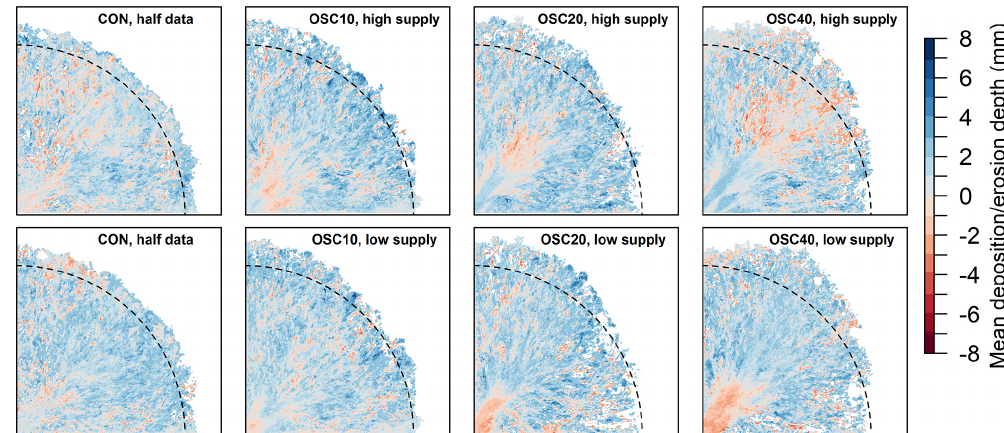
Figure 10. Spatial patterns of erosion (red) and deposition (blue). All 1min DoDs for high-supply (above) and zero-supply periods (below) were averaged to show the typical pattern. Data from Run CON are split into the same groups as Run OSC10, although the former had no sediment supply oscillations; the Run CON data show how deposition and erosion varied randomly in comparison to the spatially organised erosion and deposition in Runs OSC10–OSC40. The semicircle at 2m down-fan shows how the central fan became more elongate as the sediment supply oscillations lengthened. To maintain the same data density (and therefore signal-to-noise ratio), the data for Run CON displayed here are only from the second repeat of this experiment, which was closest to the mean slope and area across the three repeats of Run